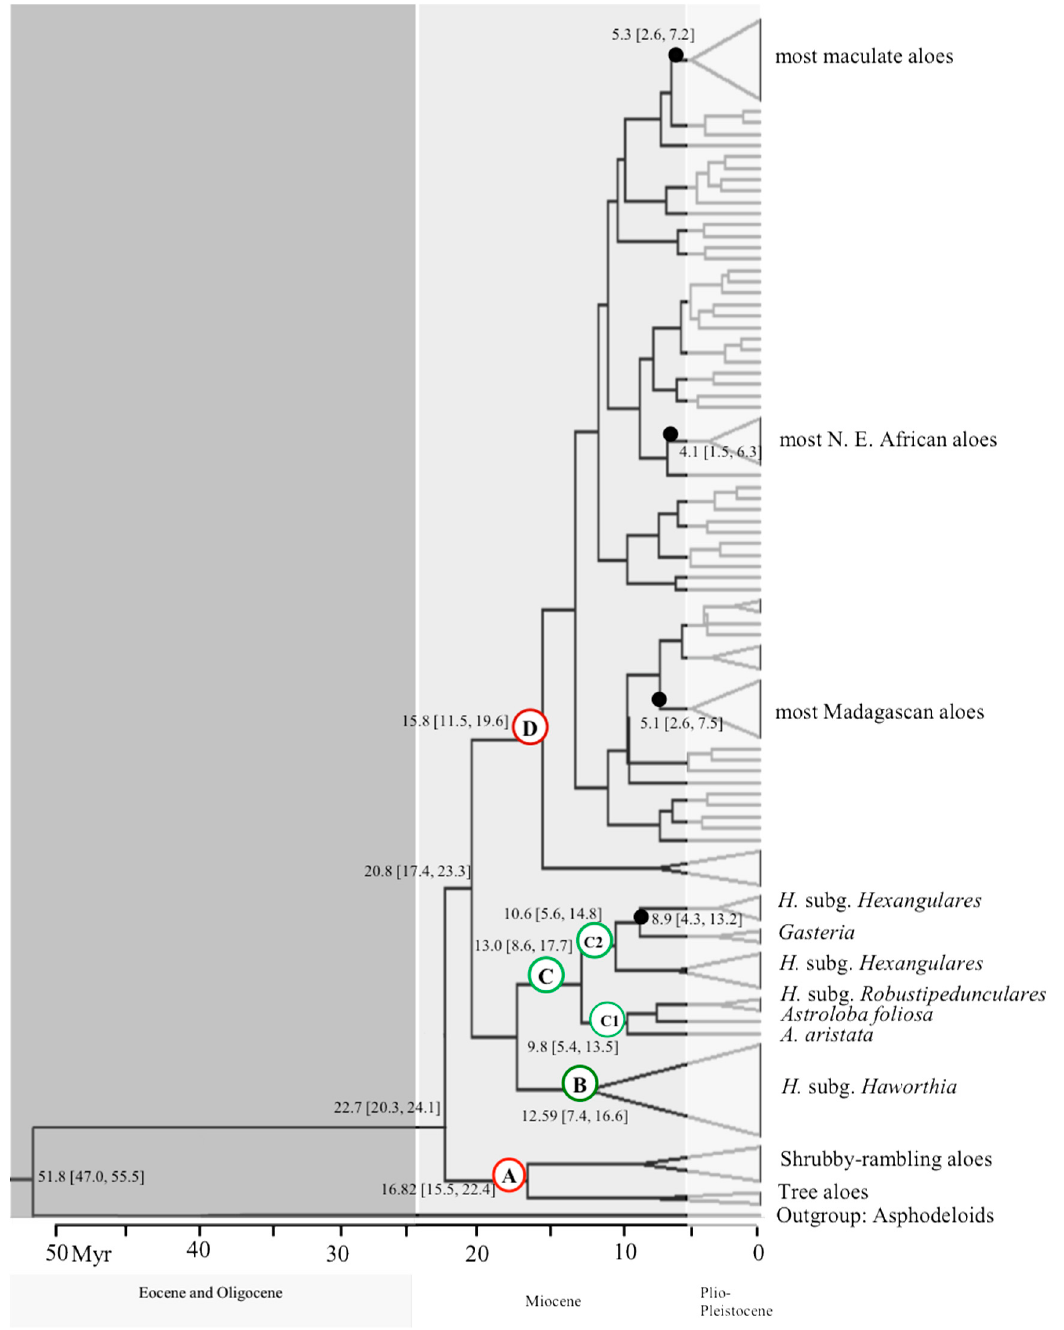
Figure 2. Estimation of divergence times in alooids. The combined maximum clade credibility tree was obtained from BEAST v1.8. Major lineages are highlighted by the letters A to D: (A) Shrubby and Tree aloes, (B) Haworthia subgen. Haworthia , (C) Haworthioids, (C1) Haworthia subgen. Robustipedunculares , Astroloba and Aloe aristata , (C2) Haworthia subgen. Hexangulares and Gasteria , (D) True aloes and Lomatophyllum .